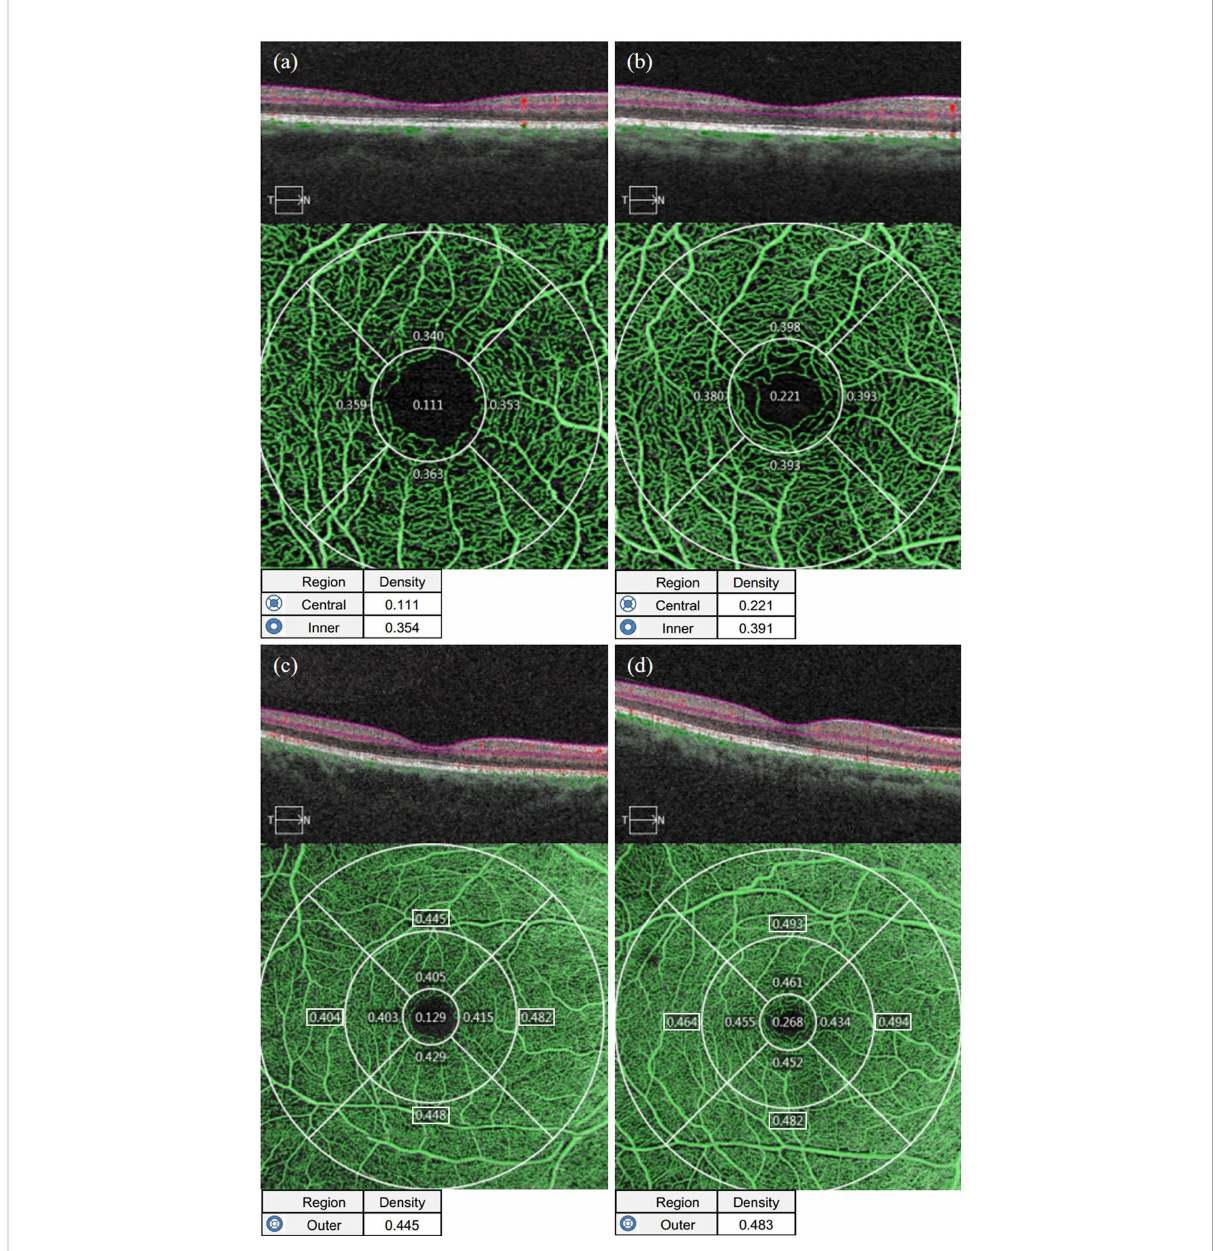
FIGURE 4 Representative OCTA images of PD measurements in the macular area of the affected eyes in the NDR group and the tested eyes in the control group. (A) Results of OCTA macular area 3 mm×3 mm B scan, the en face image of the super fi cial retina and PD of the foveal area (central item in the table, the same below), mean PD of the parafoveal area (inner item in the table, the same below), and PD in each quadrant of the parafoveal area (The corresponding region number in the fi gure, the same below) automatically measured by the system software of the right eye of a 63-year-old female NDR patient. (B) Results of OCTA macular area 3 mm×3 mm B scan, the en face image of the super fi cial retina and PD of the foveal area, mean PD of the parafoveal area, and PD in each quadrant automatically measured by the system software of the right eye of a 54-year-old female control. (C) Results of OCTA macular area 6 mm×6 mm B scan, the en face image of the super fi cial retina and PD of the foveal area (outer item in the table, the same below), mean PD of the parafoveal area, and PD in each quadrant of the parafoveal area (The corresponding region number in the fi gure, the same below) automatically measured by the system software of the right eye of NDR patients as in (A) . (D) Results of OCTA macular area 6 mm×6 mm B scan, the en face image of the super fi cial retina and mean PD of the parafoveal area, and PD in each quadrant of the parafoveal area automatically measured by the system software of the right eye of the control as in (B) . The PD results in the macular area of the NDR patients were smaller than those of the control. NDR, diabetes mellitus without diabetic retinopathy; PD, perfusion density; OCTA, optical coherence tomography